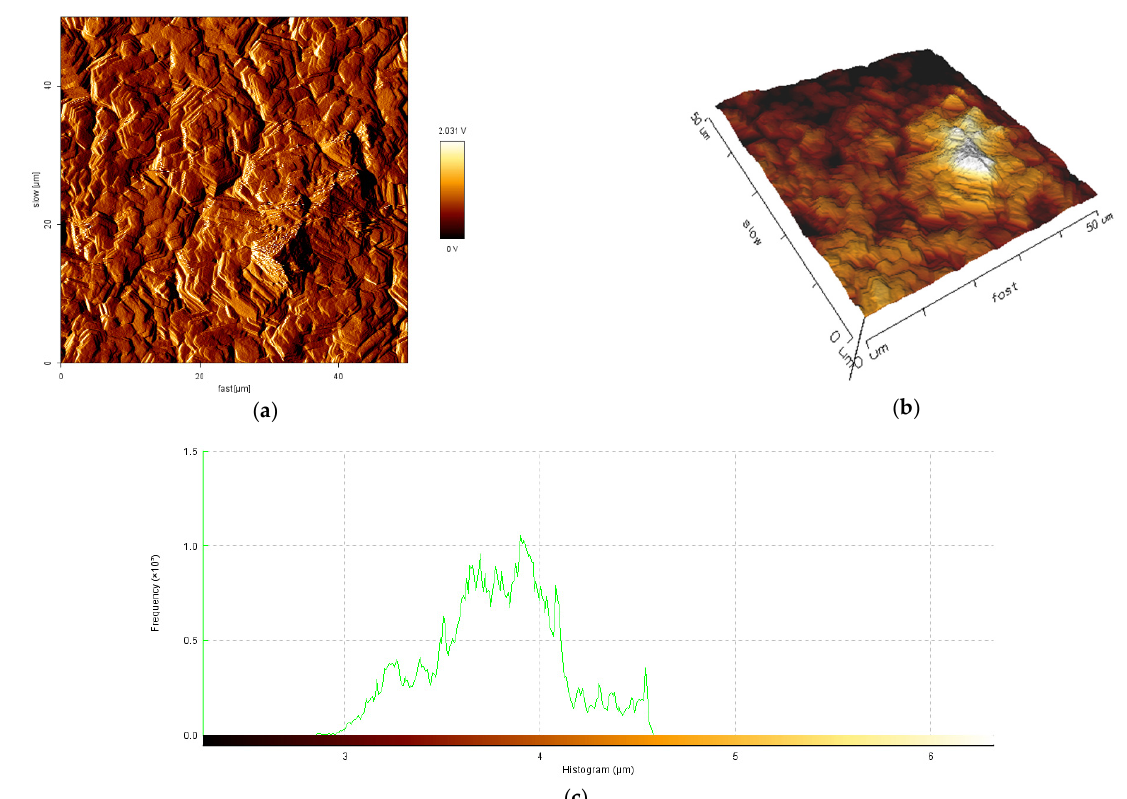
Figure 4. 50 × 50 μ m 2 Atomic Force Microscopy (AFM) images of sample A: ( a ) 2D image; ( b ) 3D image; ( c ) histogram of the scanned surfaces.